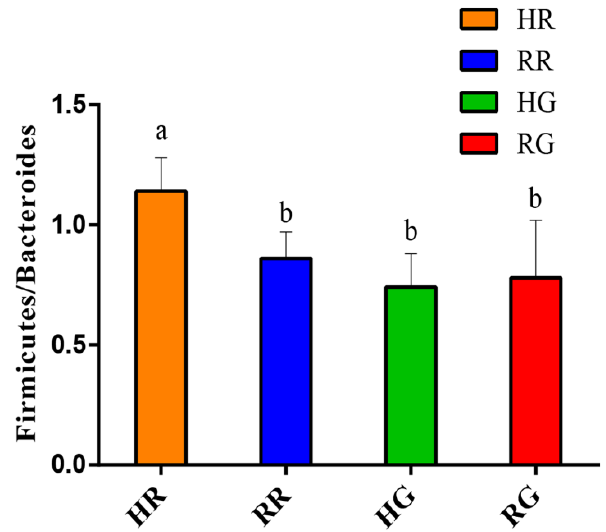
Figure 2. Fold change ( Firmicutes / Bacteroides ) in the relative abundances of the rumen bacteria of hoggets (H) and rams (R) of grazing Alpine Merino sheep under different plant phenology. HR, hoggets of grazing Alpine Merino sheep in the regreen stage; RR, rams of grazing Alpine Merino sheep in the regreen stage, HG, hoggets of grazing Alpine Merino sheep in the grassy stage; RG, rams of grazing Alpine Merino sheep in the grassy stage. Table 2. The relative abundance of bacterial taxa (relative abundance > 1% at least in one group) in rumen microbiome of hoggets (H) and rams (R) of grazing Alpine Merino sheep under different phonological periods.